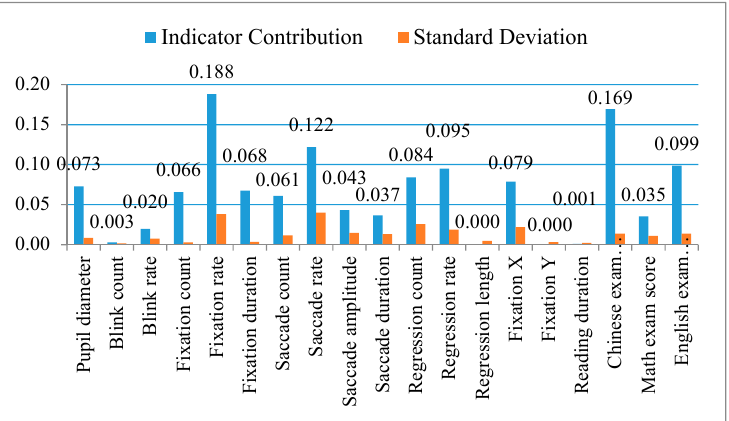
Figure 5. Eye-tracking indicator contribution in the computation model. Notes: As can be seen, fixation rate, saccade duration, and Chinese exam score were the factors that contributed most to the computational model, while blink count, fixation position Y, and reading duration contributed the least to the model. Most of the indicator contribution is consistent with the empirical data, except the blink count and blink rate, which make very little contribution to the model.